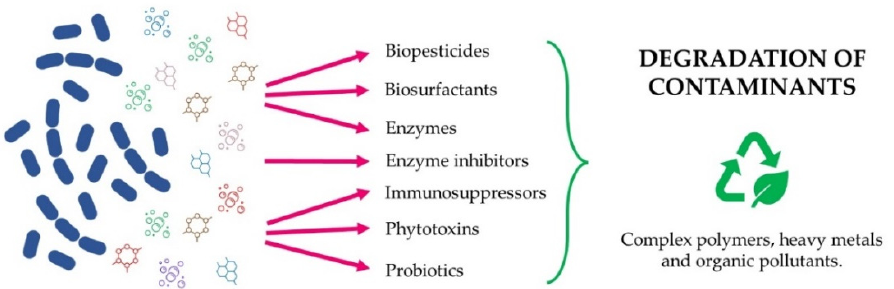
Figure 4. Schematic summary of the uses of actinomycetes from caves in the remediation of com- plex polymers, heavy metal and organic pollutant-contaminated Soils. polymers, heavy metal and organic pollutant-contaminated